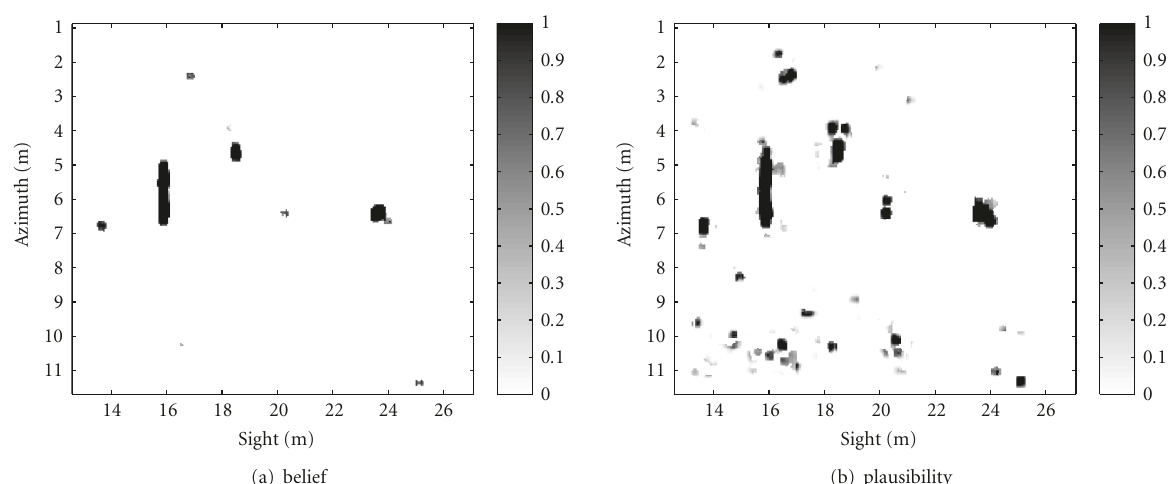
Figure 17: Belief and plausibility object images obtained after fusion of the three parameters in image